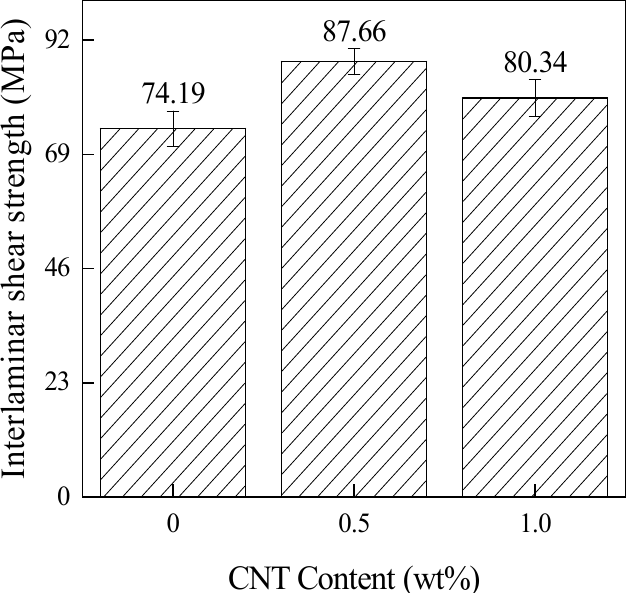
Figure 7. Interlaminar shear strength of composites with different CNT